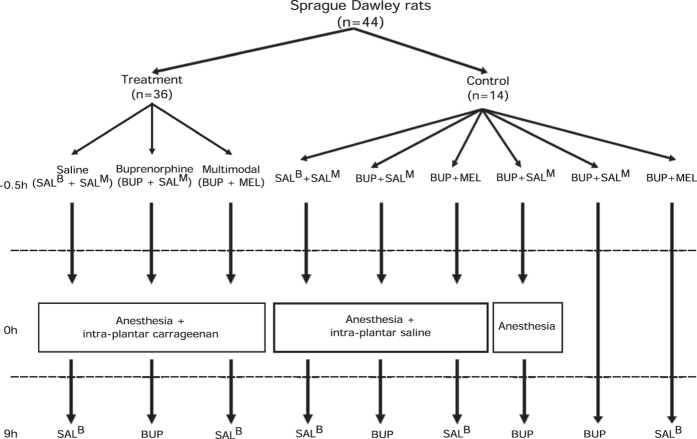
Flow chart depicting experimental pathway for each treatment group.SALB, saline volume equivalent to buprenorphine dose. SALM, saline volume equivalent to meloxicam dose. BUP, buprenorphine. MEL, meloxicam.